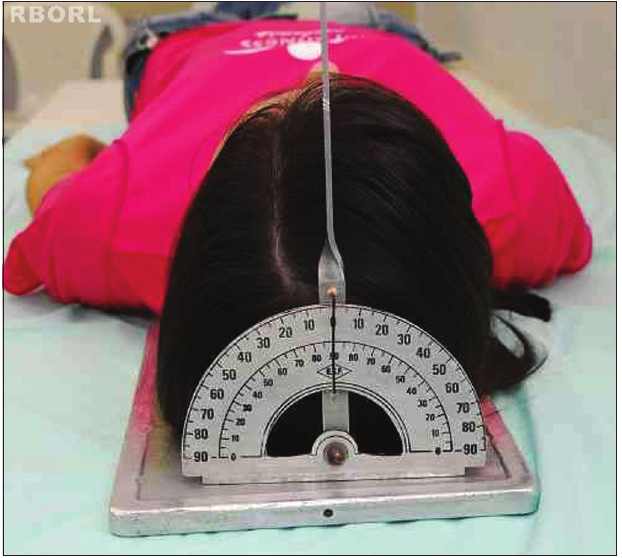
Figura 1 . Posicionamento - plano sagital mediano em 90 ° com a horizontal: Transorbitária (vista posterior).